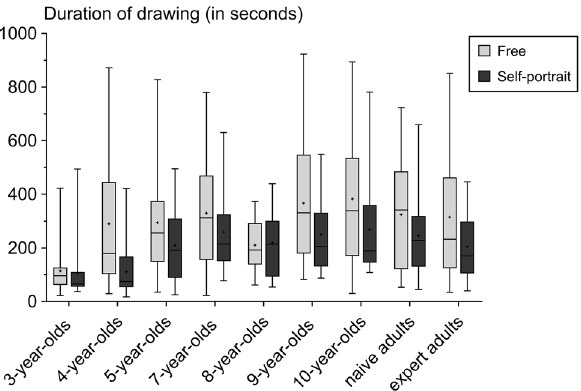
Figure 2. Boxplots of drawing duration (in seconds) for each group and for each condition. Boxplots depict the median (bold bar), 25–75% quartiles (box), mean (cross) and outliers